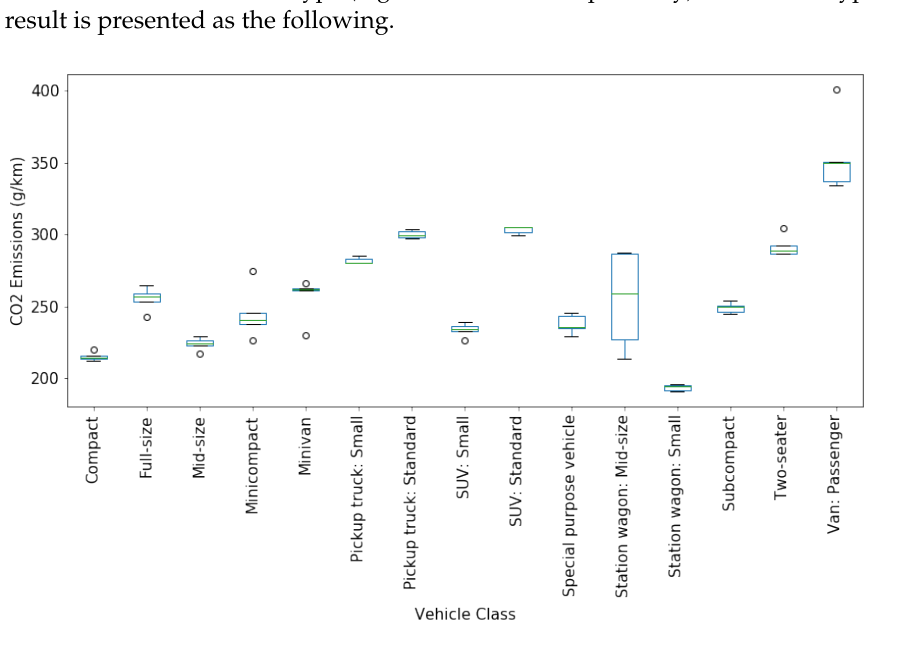
Figure 10. CO 2 emissions of each vehicle class over